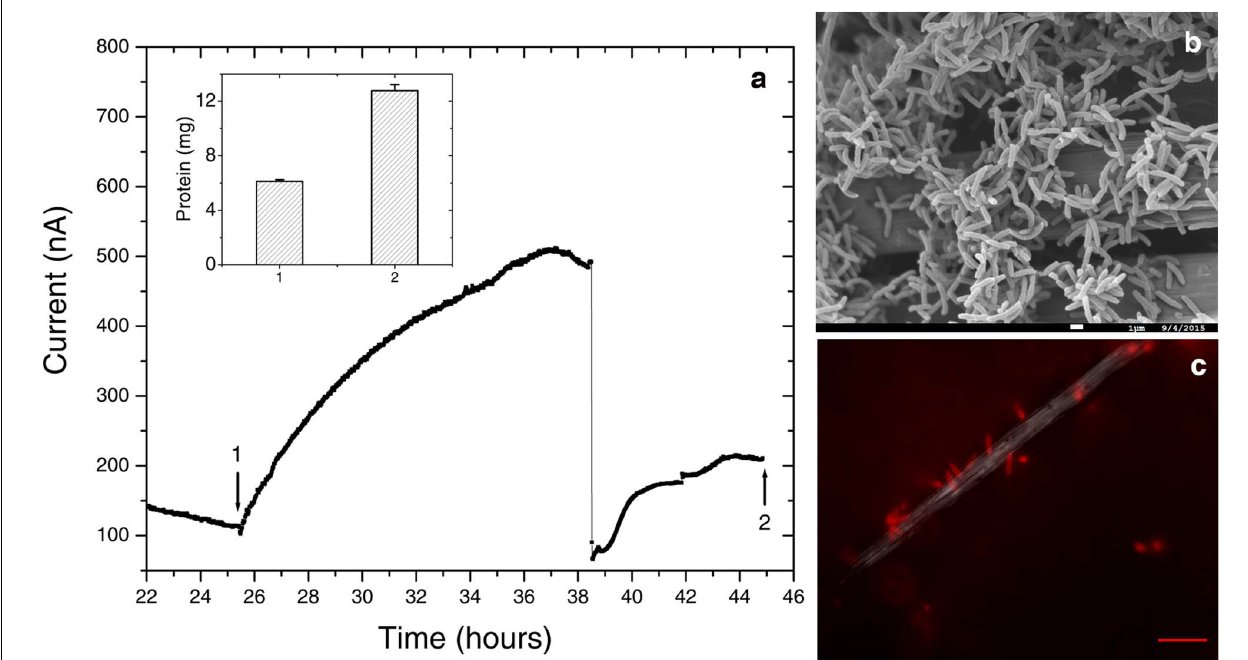
FIGURE 6 | Further electrochemical and microscopic characterization of Delftia sp. WE1-13. (a) Medium change resulted in a sudden decrease of anodic current, as observed in the enrichment cultures. Inset shows total protein content measured at the time points marked 1 and 2. (b) Scanning electron microscopy (1 µ m scale bar) shows attachment of the rod-shaped of Delftia sp. WE1-13 on the carbon cloth fibers. (c) In vivo fluorescent image (FM 4-64FX membrane stain) confirms the attachment of Delftia sp. WE1-13 cells to the electrode during electrochemical analysis (10 µ m scale